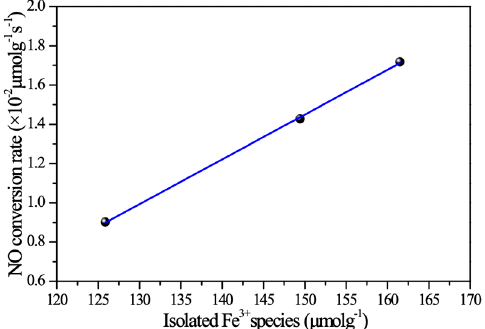
Figure 11. Correlations of the NO conversion rate at 200 °C with the isolated Fe 3+ content on Fe/Beta catalysts.